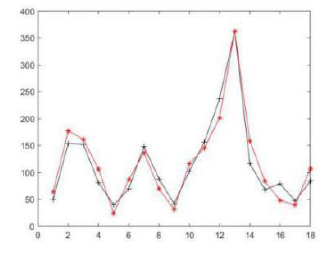
Figure 2. Forecast